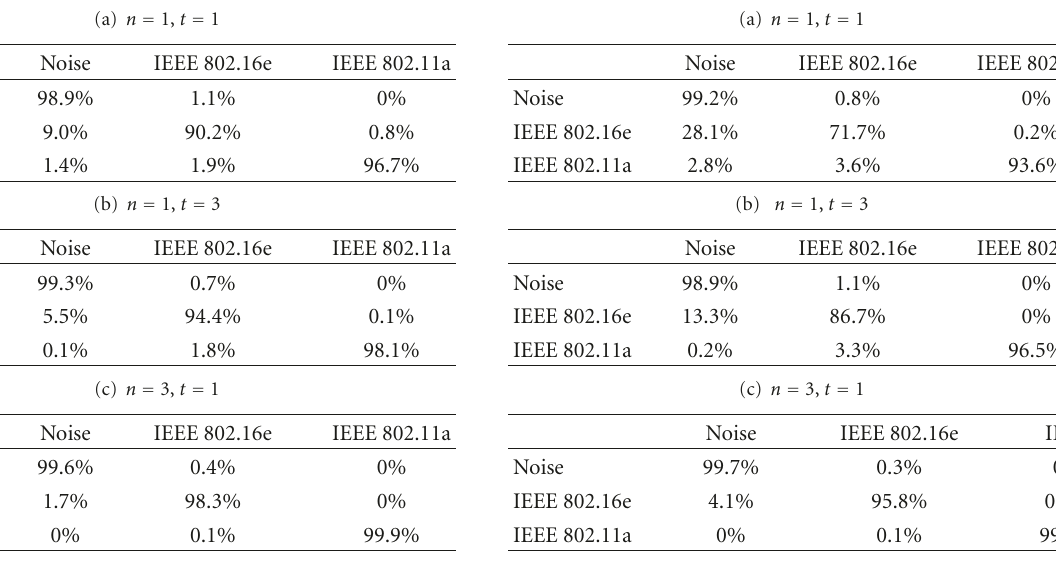
Table 2: Confusion matrices for T obs = 2ms. Table 3: Confusion matrices for E b /N 0 = − 5